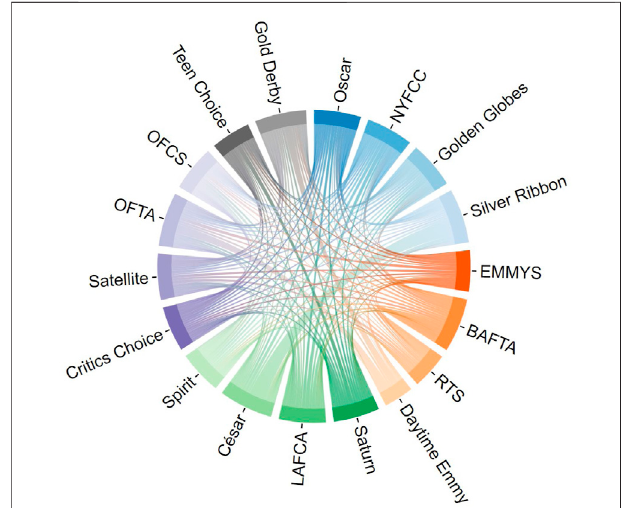
FIGURE 5 | Prestigious awards. The top prestigious network selected by h-index. The stripe width between each plot is weighted by the degree of each prize in the co-awarding network compared with the null model (random graph). Compared with random graphs, some awards show very strong connections, for example, the link weight between the César Award and the Silver Ribbon is